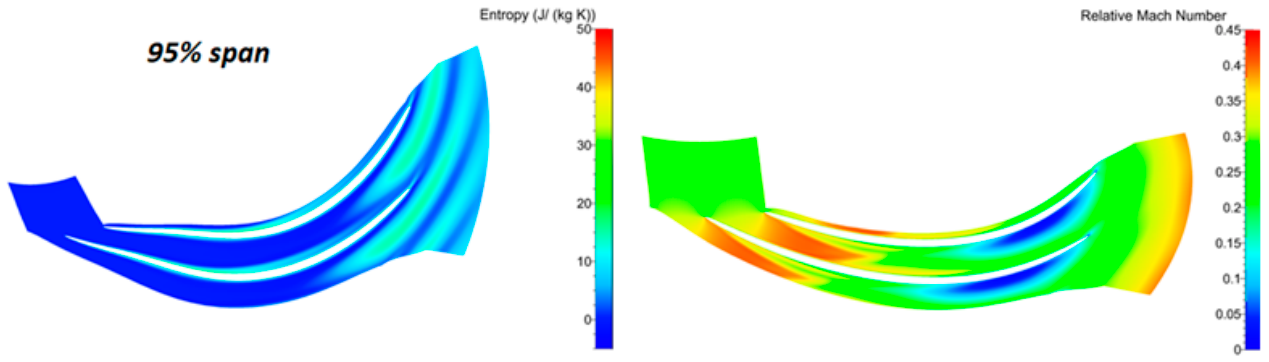
Figure 26. Contours of entropy and relative mach number at 95% span showing S ‐ shaped profile. The single ‐ stage centrifugal compressor has a high pressure ratio compared with an axial compressor, and a multistage centrifugal compressor is not as efficient because the flow has to turn from radial at the outlet to axial at the inlet for the next stage. A novel in collaboration with Mishra [83], Shaaban Abdallah and Sai Muppana [85] which utilizes the efficient axial and radial compressor flowpath as shown in Figure 27 by splitting the single rotor into an axial rotor, stator, and a purely radial rotor on a single disk.